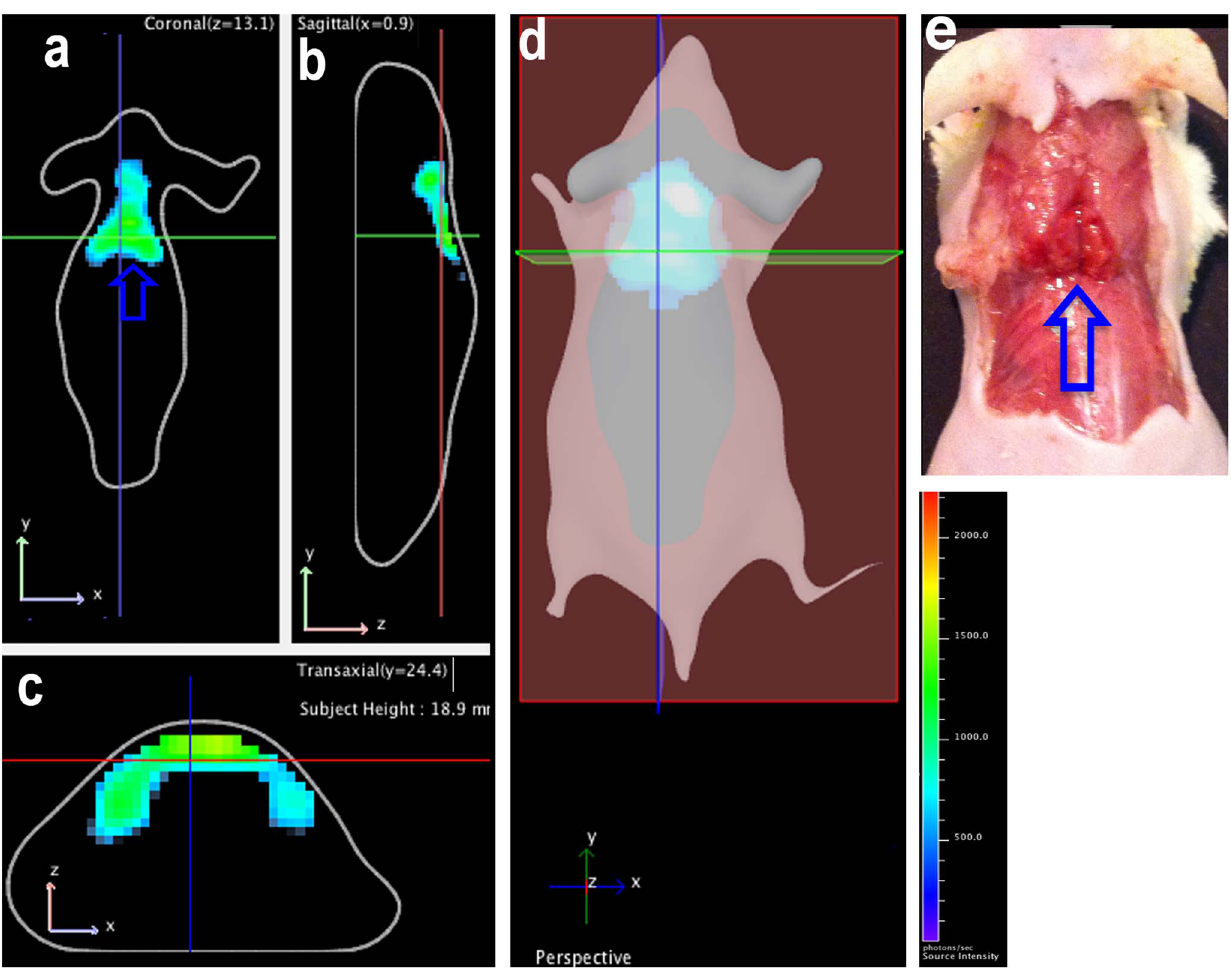
Figure 6. Multispectral Cerenkov luminescence tomography. (a–d) 3D reconstruction of the images. Interscapular BAT could be seen in coronal (a), sagittal (b), and transverse views (c), as well as in the 3D image (d); (e) Physical BAT shape is shown (blue arrow) which correlated with reconstructed images.